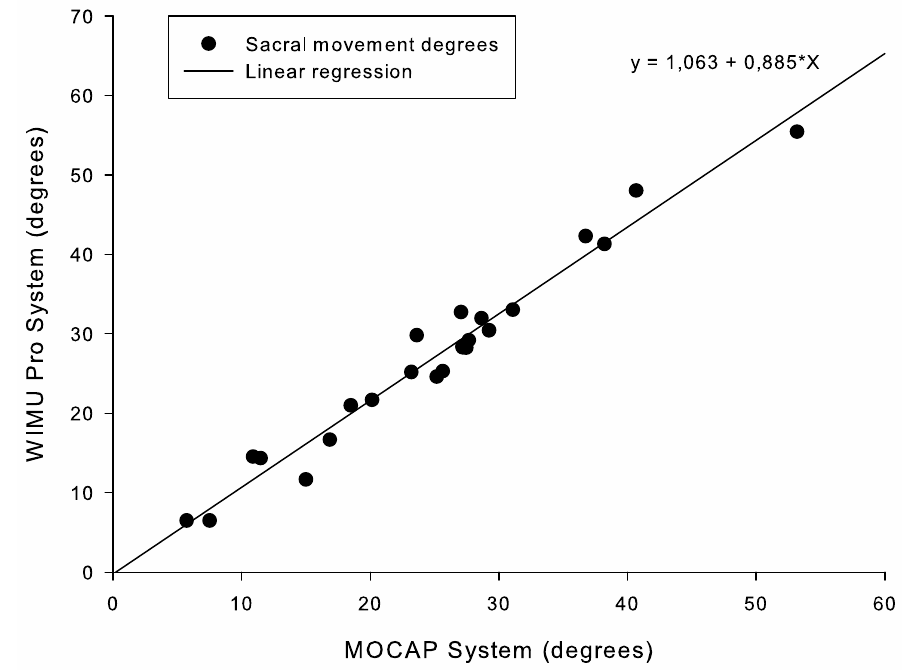
Figure 4. Correlation between systems for range of motion monitoring during slow IOCs .